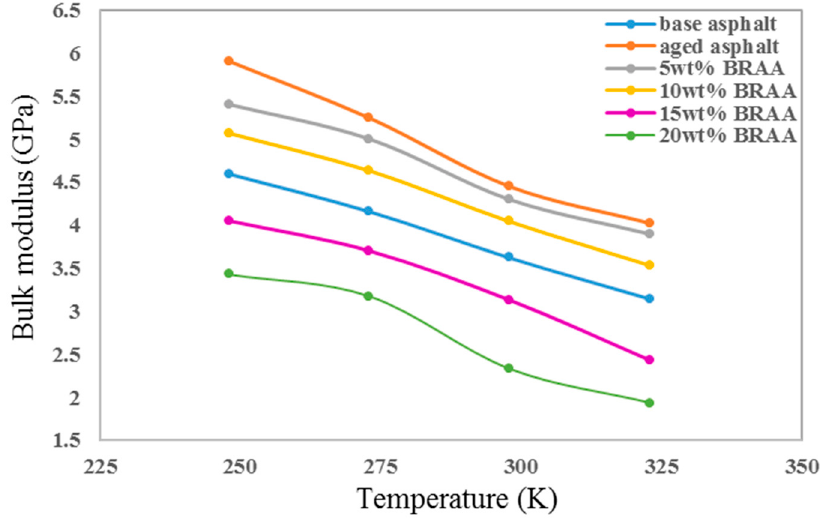
Figure 8. Bulk moduli of asphalt systems at different temperatures.